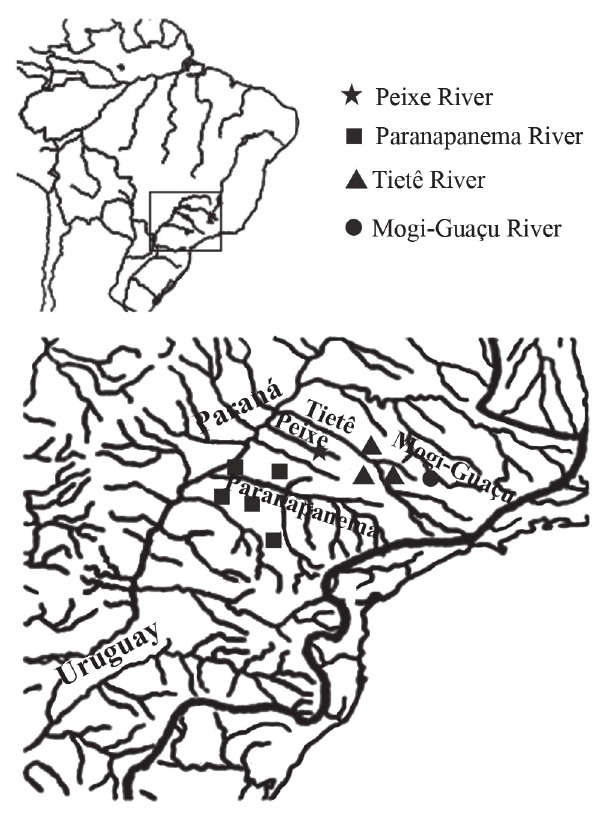
Fig. 2. Map of the river system in Brazil, highlighting the upper rio Paraná basin and the collection